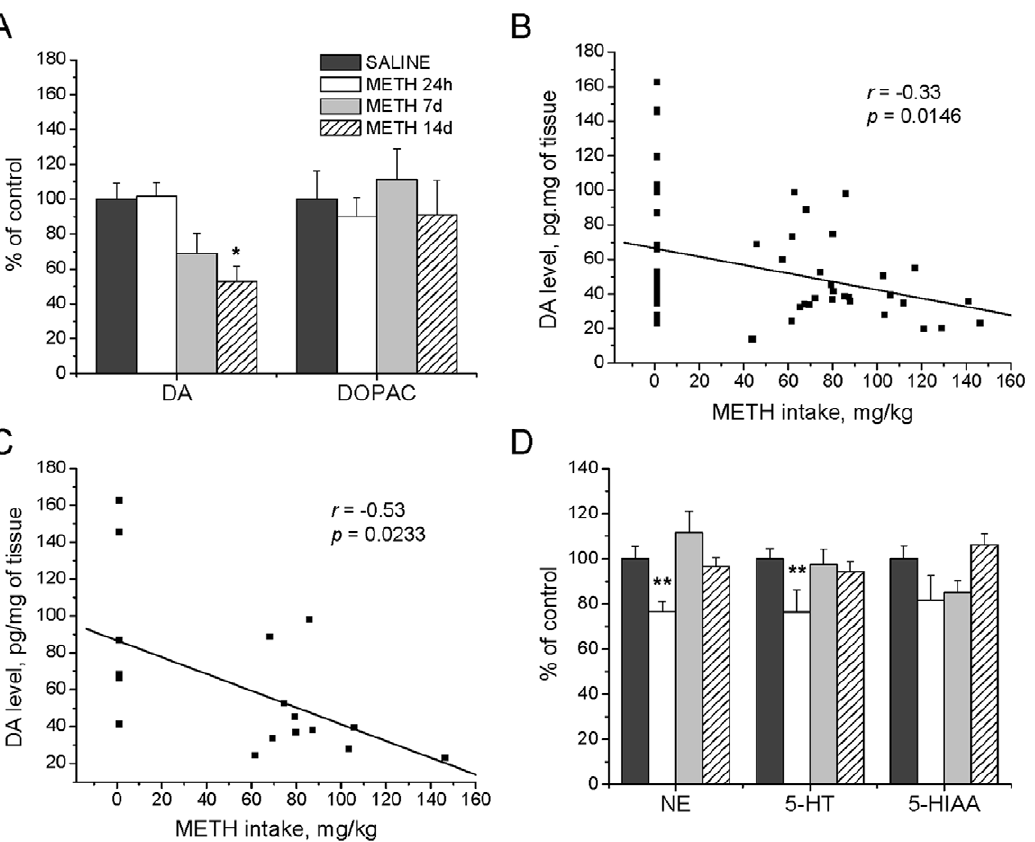
Figure 3. Effects of METH self-administration on monoamine levels in the cortex. METH self-administration resulted in long-term reductions in DA concentrations in the cortex (A). DA levels showed negative correlations with total METH intake at the 24 hour, 7 and 14 days time- points (B) and at 14 days after cessation of self-administration (C). METH caused only transient reductions in NE and 5-HT concentrations in the cortex (D). Data shown as mean 6 SEM. *, p , 0.05; **, p , 0.01 vs control. Data were analyzed by ANOVA followed by PLSD, n=7 2 11 per group. Correlation analysis was done by regression analysis.